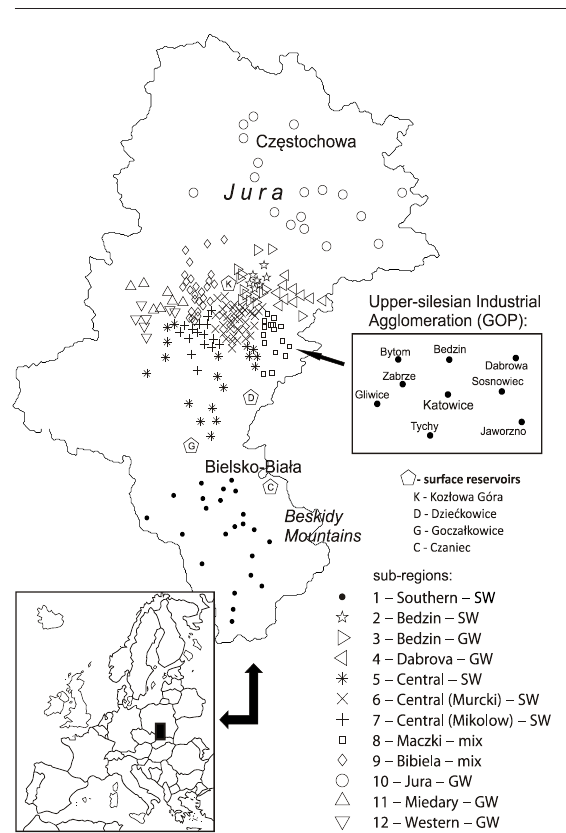
Figure 1. Arrangement of 201 sampling places, mainly cities and reservoirs in the Silesian District contour map; SW – water from surface reservoirs and rivers, GW – groundwater supply, mix – a mixture of surface and